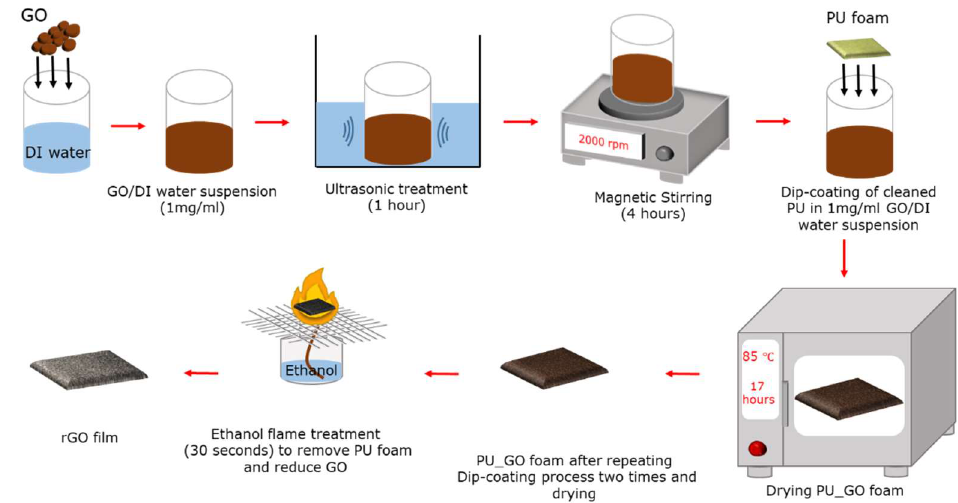
Figure 1. Fabrication process of rGO film.